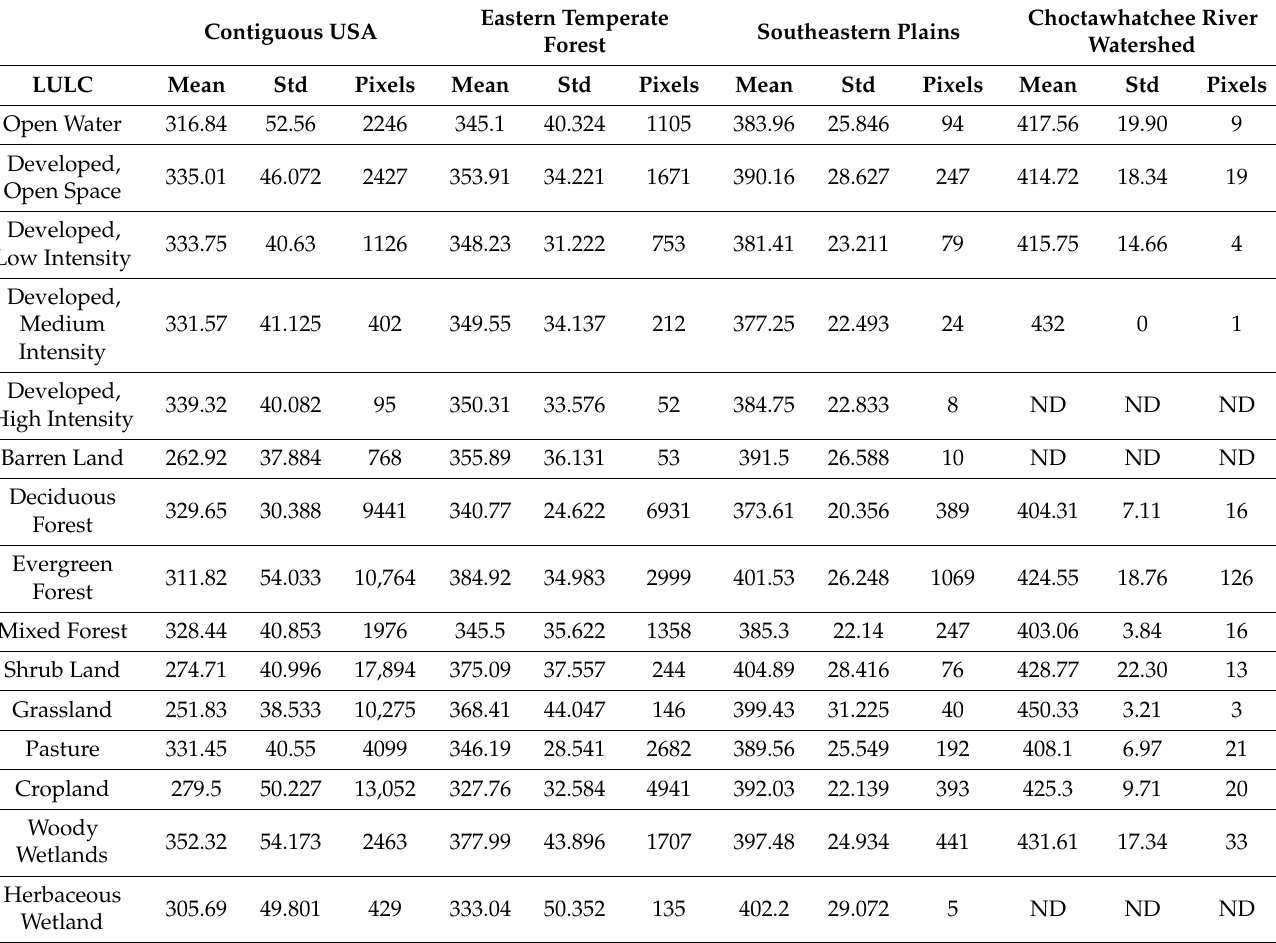
Table 3. The average and standard deviation of the species richness for each land use/cover